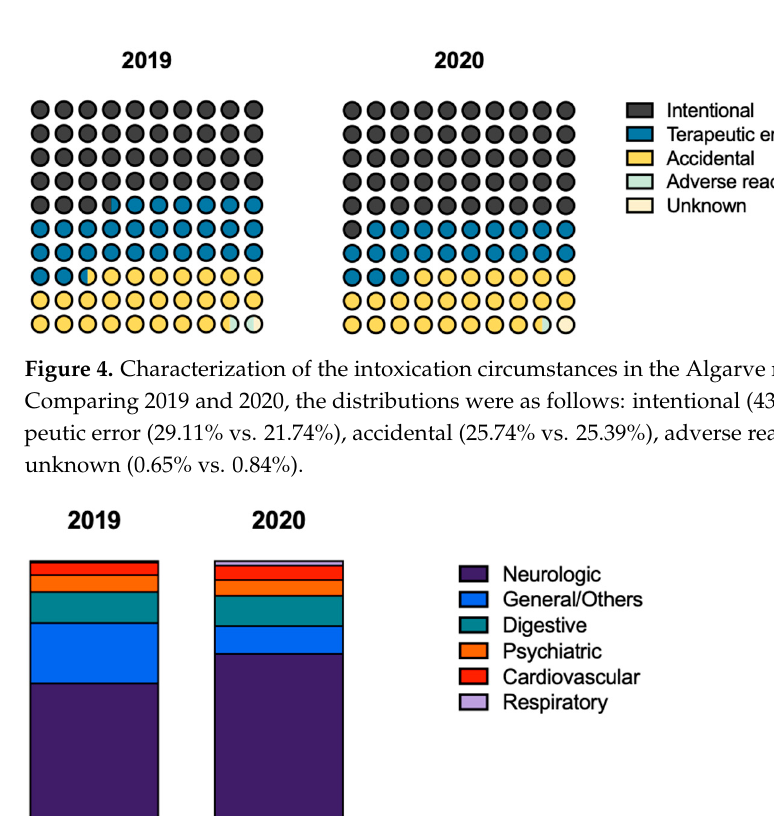
Figure 5. General symptoms grouped by main system affected described in the calls to the Poison Information Centre in the Algarve region in 2019 and 2020. Comparing 2019 and 2020, the distribu- tions were as follows: neurologic (52.54% vs. 64.06%), general/others (23.45% vs. 10.73%), digestive (12.15% vs. 11.88%), psychiatric (6.45% vs. 6.09%), cardiovascular (4.80% vs. 5.51%), respiratory (0.57% vs. 1.74%). Percentages were calculated by the total of symptomatic cases.